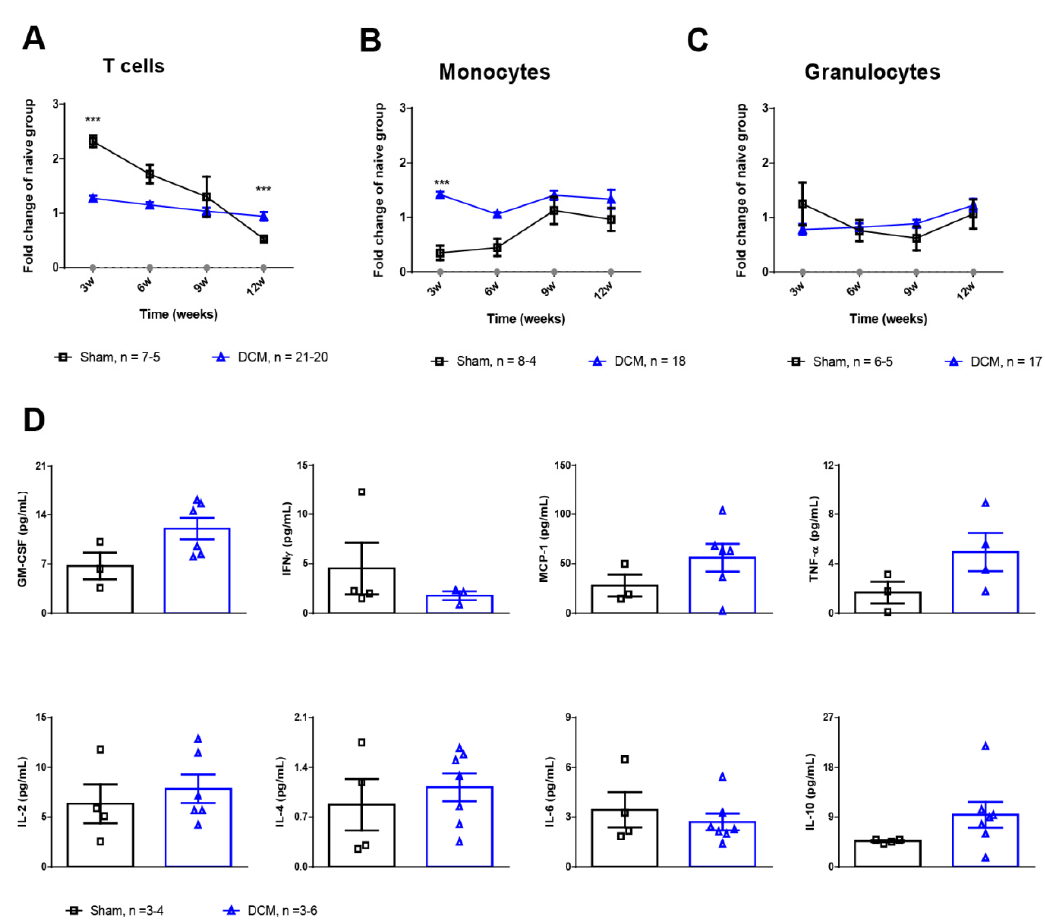
Figure 3. Systemic cellular and cytokine changes after DCM. Flow cytometric quantification of the frequency of circulating T cells (CD3 + ) ( A ) monocytes (Ly6C + CD11b + Ly6G − ) ( B ) and granulocytes (Ly6G + CD11b + Ly6C − ) ( C ) at 3, 6, 9 and 12 weeks after DCM induction, as compared to the sham group. All values are reported as fold-change relative to age-matched naïve mice. Asterisks indi- cated differences between groups within each time point. Naive = 6; Sham = 4–8; DCM = 17–21. ( D ) Quantitation of selected inflammatory and anti-inflammatory cytokines in serum at 12 weeks after DCM induction using a Luminex xMAP assay. Data are presented as mean ± SEM. Sham = 3–4; DCM = 3–6.